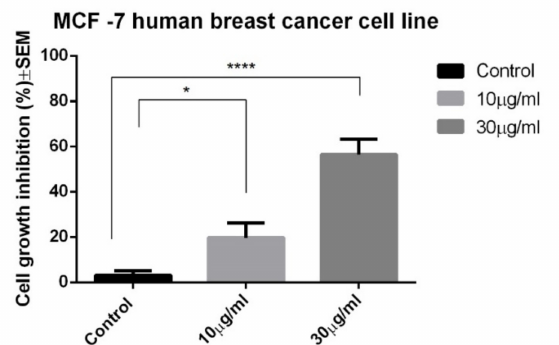
Figure 2. The cell growth inhibition for the MCF-7 human breast cancer cell line after 72 h of incubation with EA. SEM, standard error of the mean.